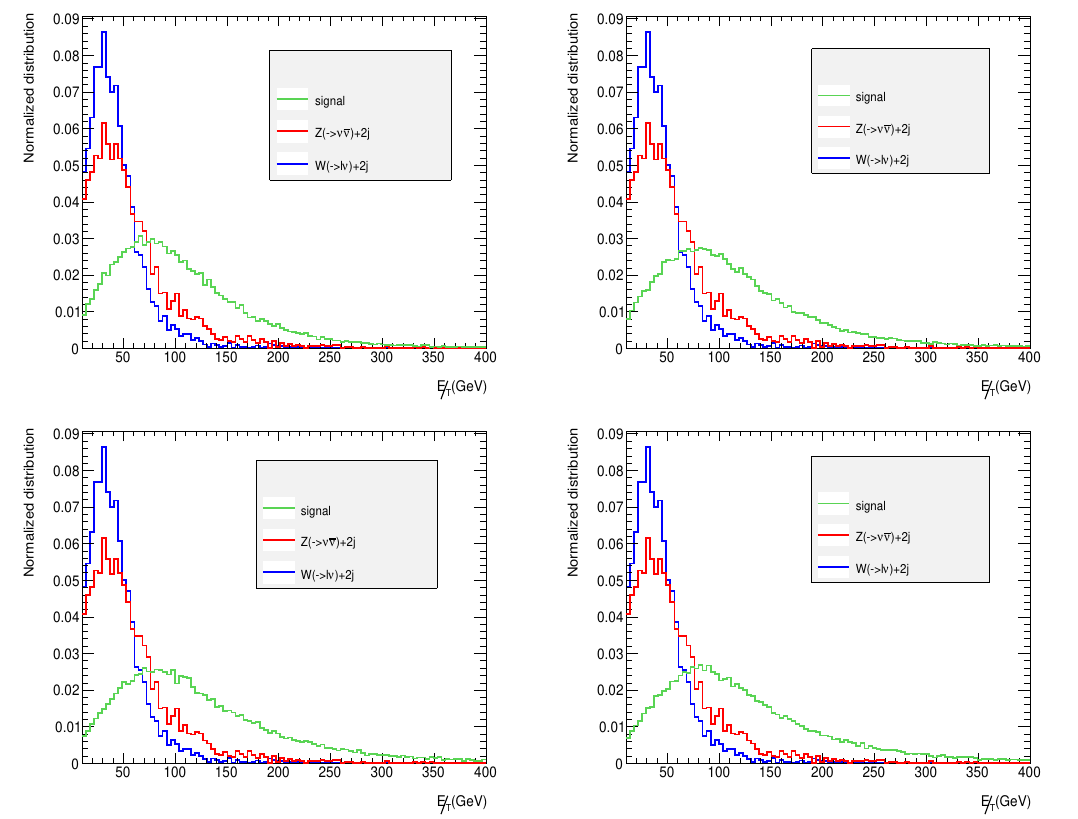
Figure 12 . =E T distribution for vector boson fusion signal and background processes, Type I BP I(top left), Type I BP II(top right), Type II BP I(bottom left) and Type II BP II(bottom